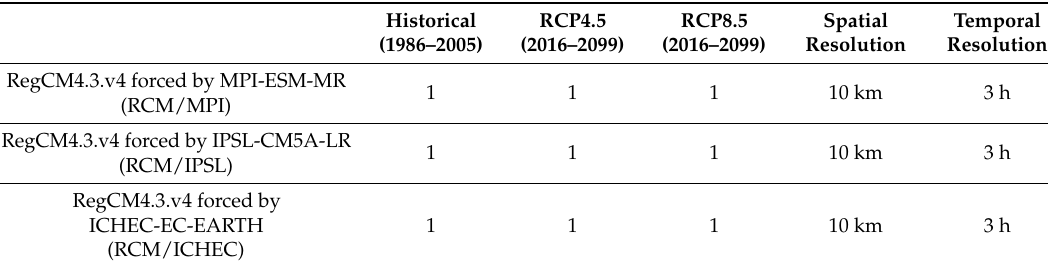
Table 1. Climate models and number of